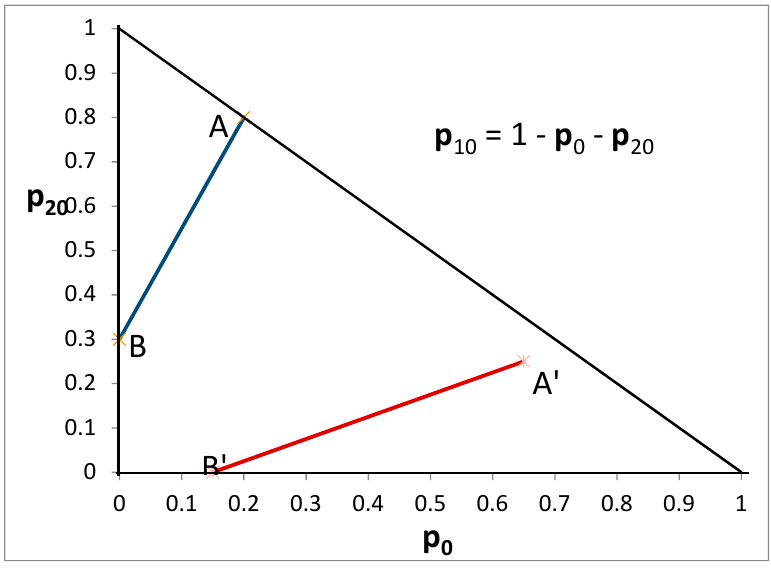
Figure 1. Example of lottery choice pairs.